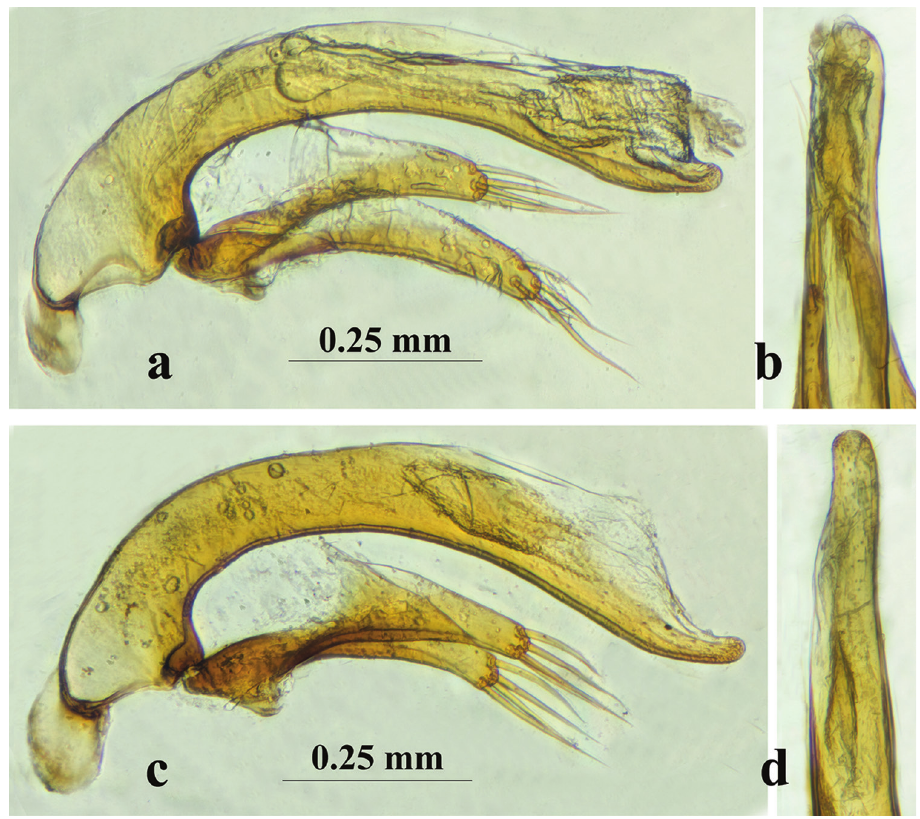
(dorsal view) a, b D. tonywhitteni sp. n. c, d D. grandis